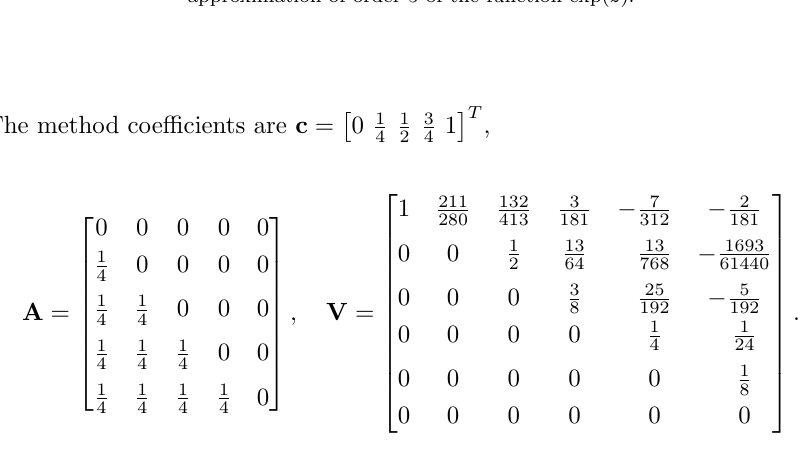
Figure 9. Stability regions of GLMs with p = q = s = 5, r = 6 with IQS and of an approximation of order 5 of the function exp( z ).